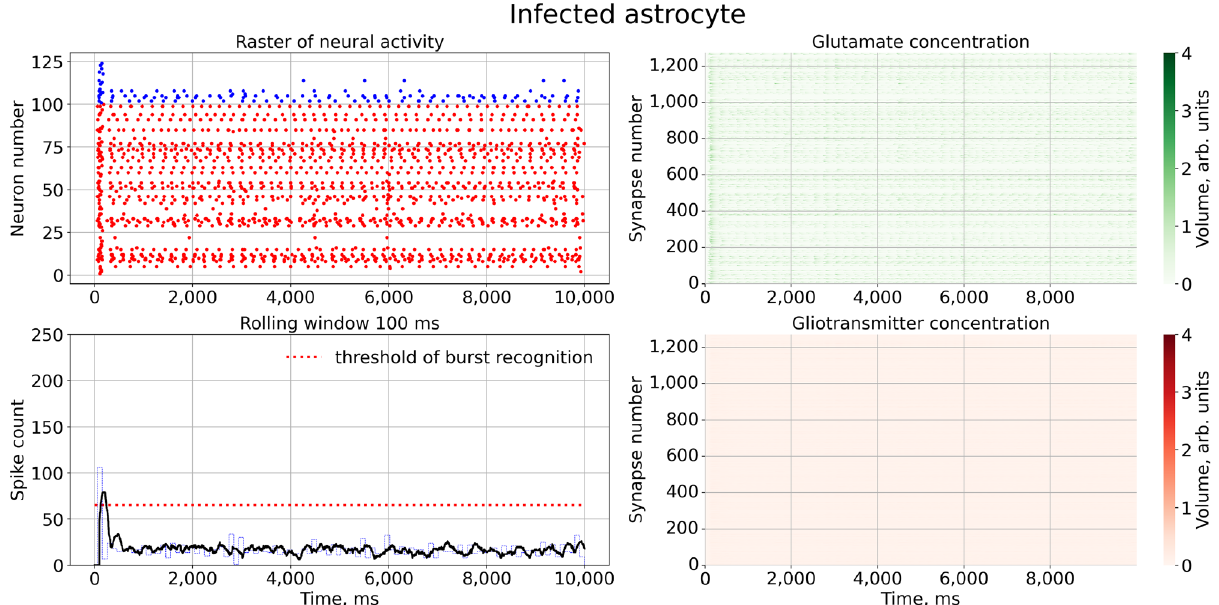
Figure 6. Raster chart of neural activity and dependences of gliotransmitter and neurotransmitter concentration from time with infected astrocyte feedbacks for γ virus = 0.8 .